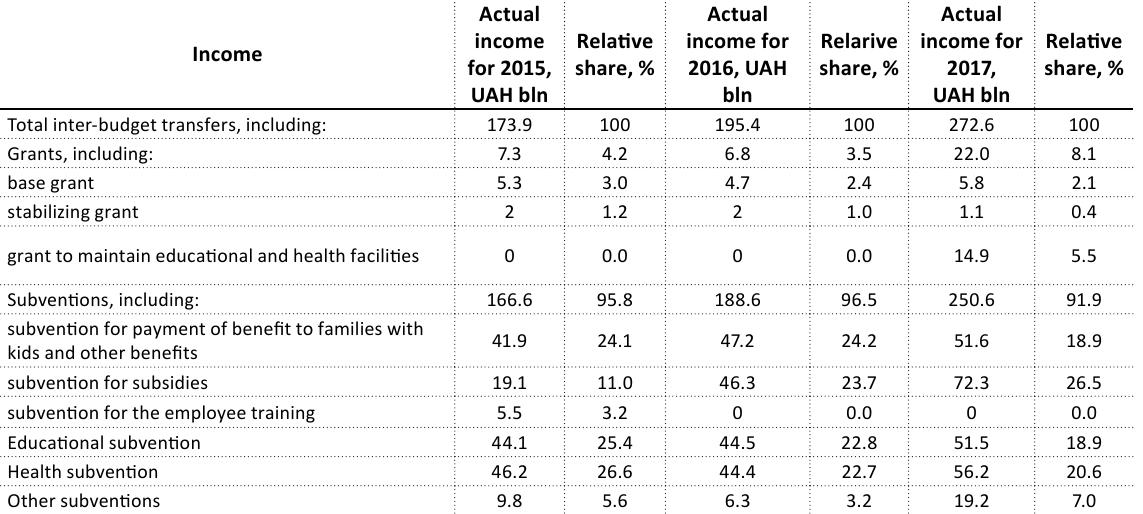
Table 3. Dynamics of the inter-budget transfer structure for 2015–2017 Income